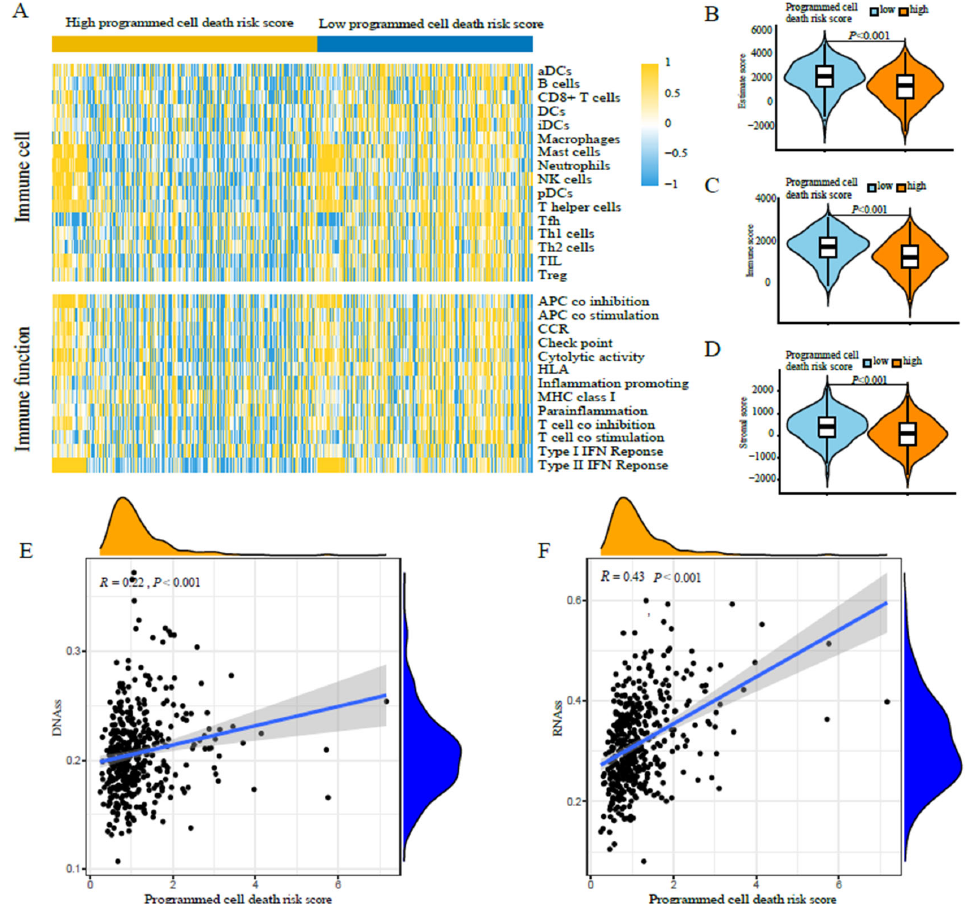
Figure 5. Exploration of differences in tumor immune microenvironment between the high and low programmed cell death risk score groups of the training cohort. ( A ) ssGSEA for the association be- tween immune cell subpopulations and related functions. ( B ) The relationship between programmed cell death risk score and the estimate risk score. ( C ) The relationship between programmed cell death risk score and the immune risk score. ( D ) The relationship between programmed cell death risk score and the stromal risk score. ( E ) The programmed cell death risk score was positively correlated with DNAss. ( F ) The programmed cell death risk score was positively correlated with RNAss.